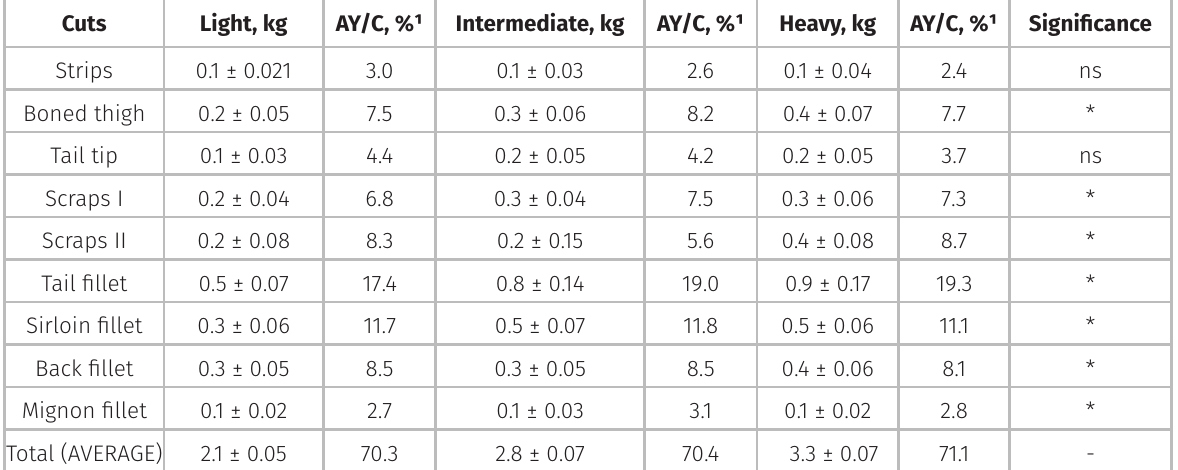
¹Average yield/carcass